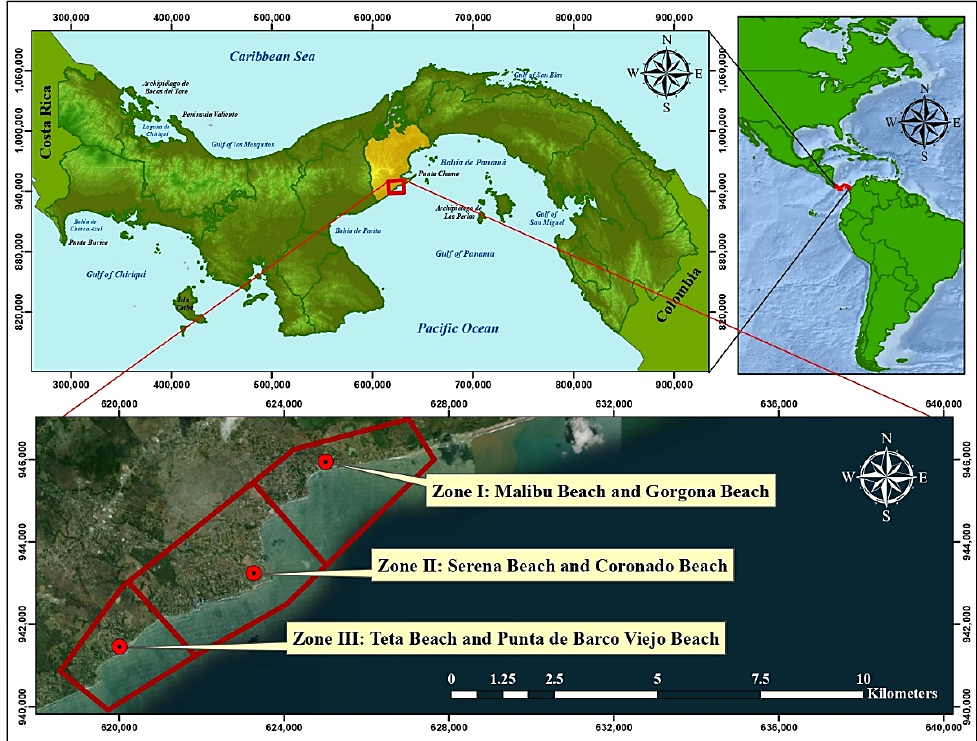
Figure 1. Map of the study zone located on the Pacific Coast of Panama.